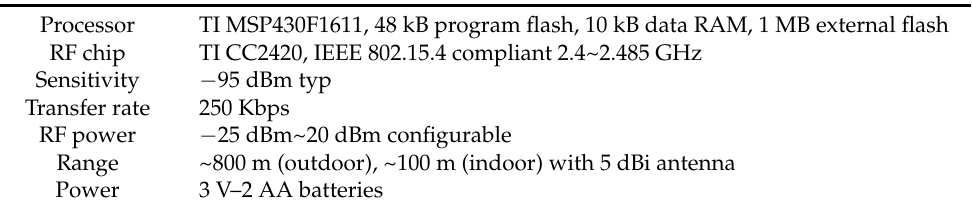
Table 2. CM3300 main